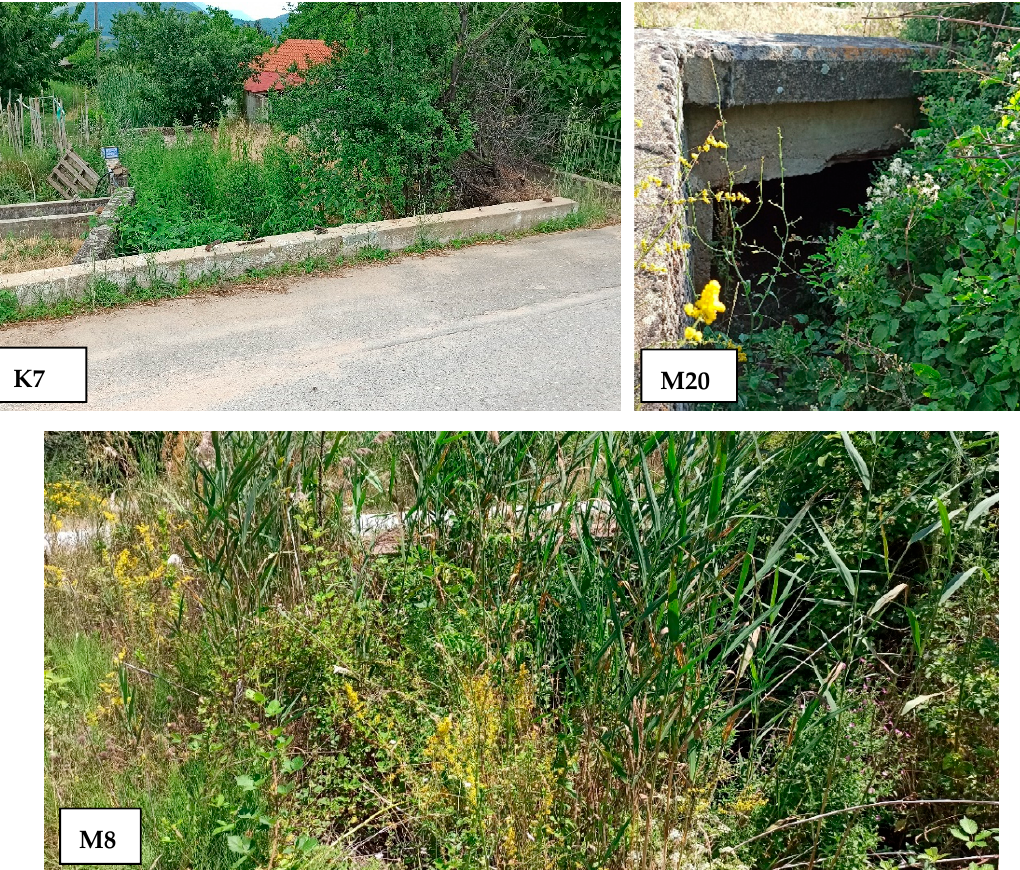
Figure 8. Representative pictures of the selected hydrotechnical works for the hydrological analysis. ( AG18 ):bridge; ( LE6 ):culvert; ( LE3 ):culvert; ( YP12 ):culvert; ( YP9 ):culvert; ( YP7 ):bridge; ( MH2 ):concrete pipe; ( PL4 ):culvert; ( KA8